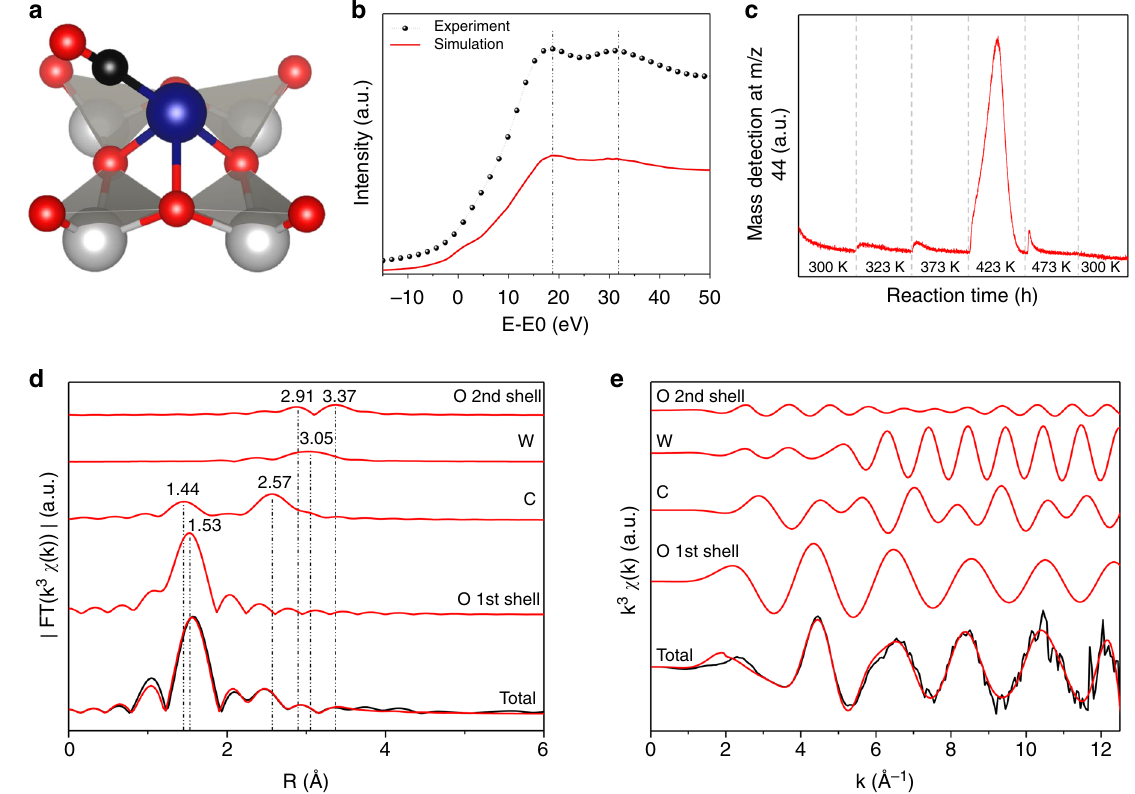
Fig. 3 Re-oxidation of the catalyst under oxygen atmosphere. a DFT-optimized structure of the intermediate of the catalyst under oxidative conditions. Atom colors: W (gray), O (red), C (black), Rh (blue). b best fi t for the XANES simulation of the catalyst structure depicted in a . c Temperature dependence of the formation of CO 2 during the treatment under O 2 as determined by online mass spectrometry. d , e EXAFS analysis of structure a in d R and e k space. Curves from bottom to top are the experimental scattering contributions (black) superimposed with the total fi tted scattering contributions, Rh – C, Rh – O (1 st and 2 nd shell) and Rh – W scatterings (all in